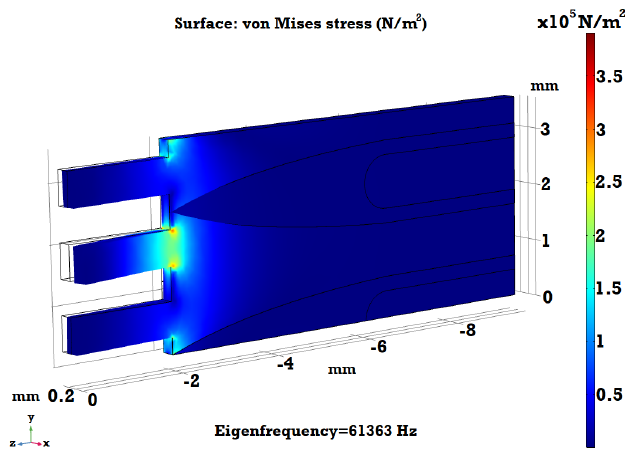
FIGURE 18. Stress at First Mechanical Eigenfrequency.